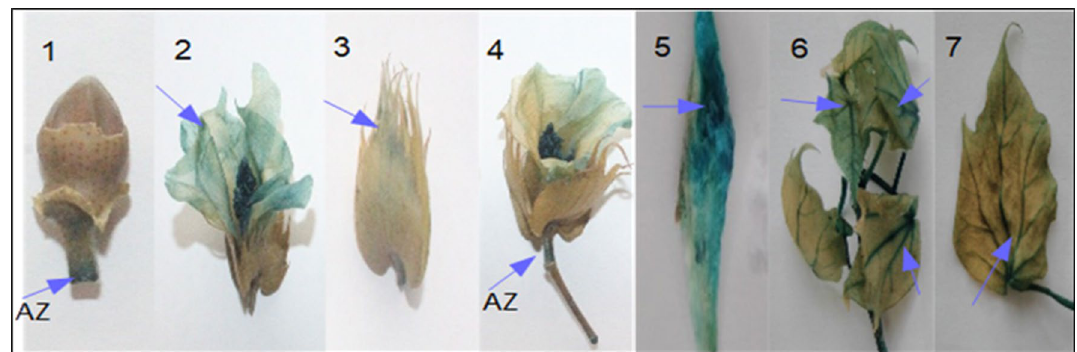
Figure 2. GUS staining of different parts of plants (1) Floral bud AZ (Abscission zone) (2) Petals (3) Sepals (4) flower AZ (5) Fiber (6) Fresh young leaves (7) Senescence